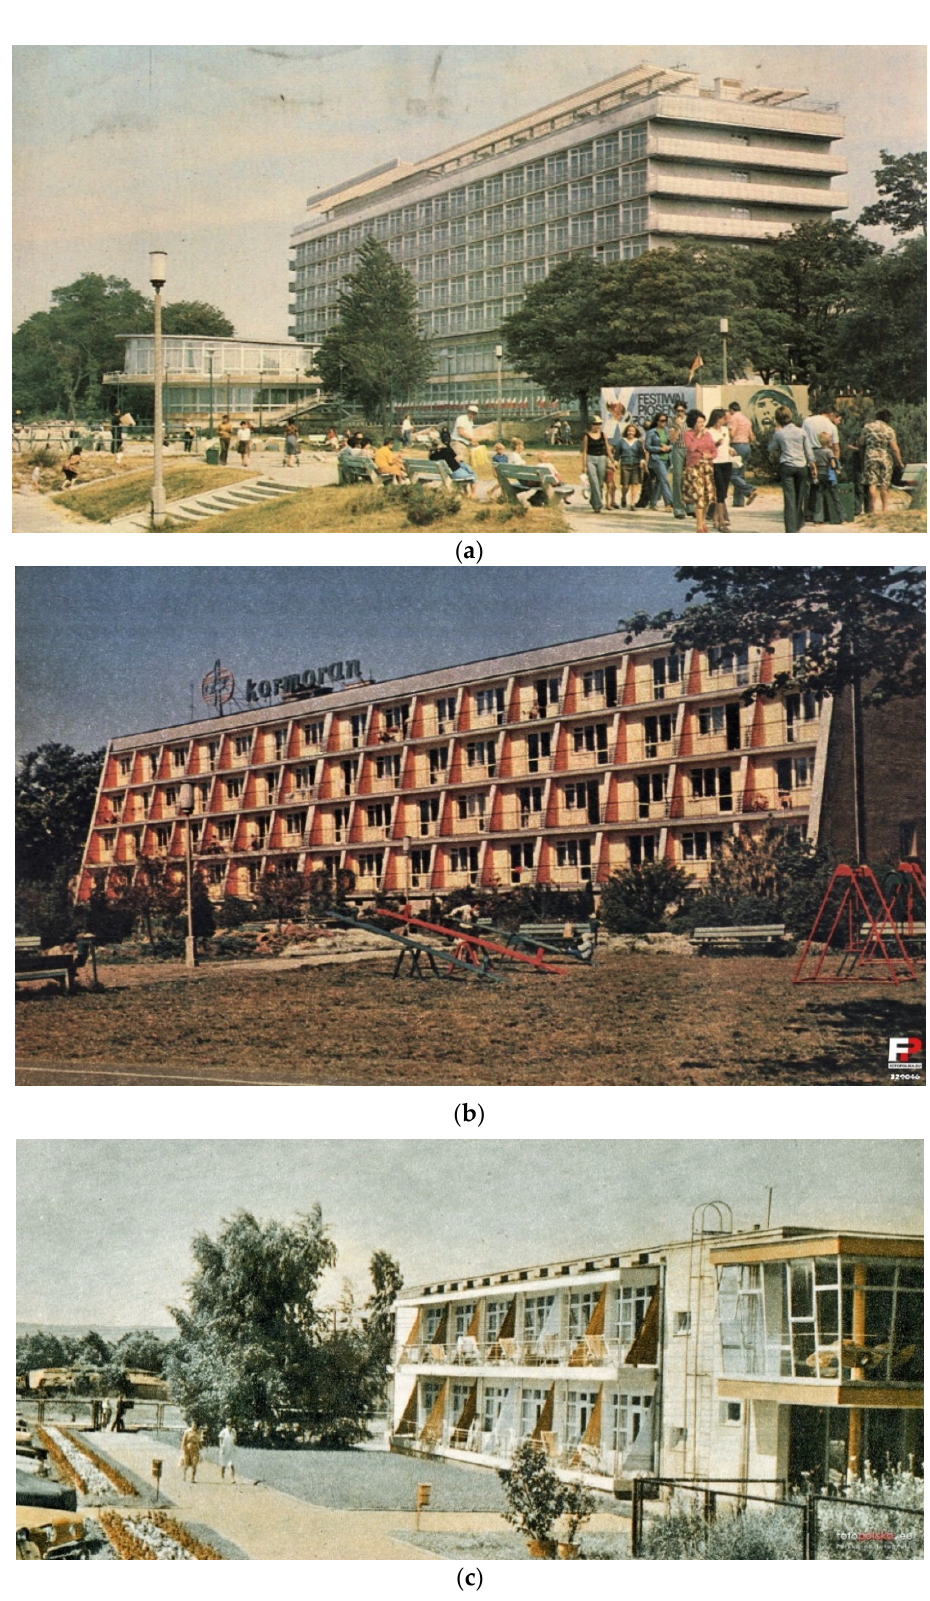
Figure 8. Architecture of the 1960s and 1970s: Health Resort Sanatorium “Baltic” ( a ) and Sanatorium Kormoran in Kołobrzeg ( b ), Recreation Centre “Rzemie´slinik” in Jelitkowo ( c )—a postcard (1960–1963), Sources: Fotopolska.eu. ( a , b ). Fot. J. Rydzewski, Journal “Morze”, no. 524 ( c ).